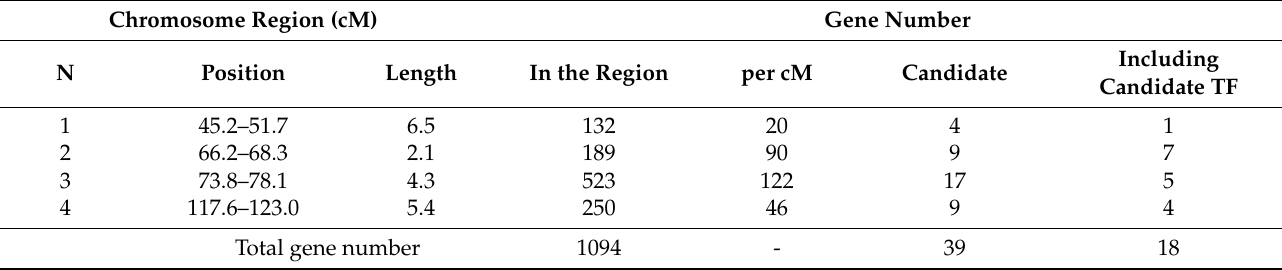
Table 4. Distribution of genes in the regions of chromosome 2A containing QTL